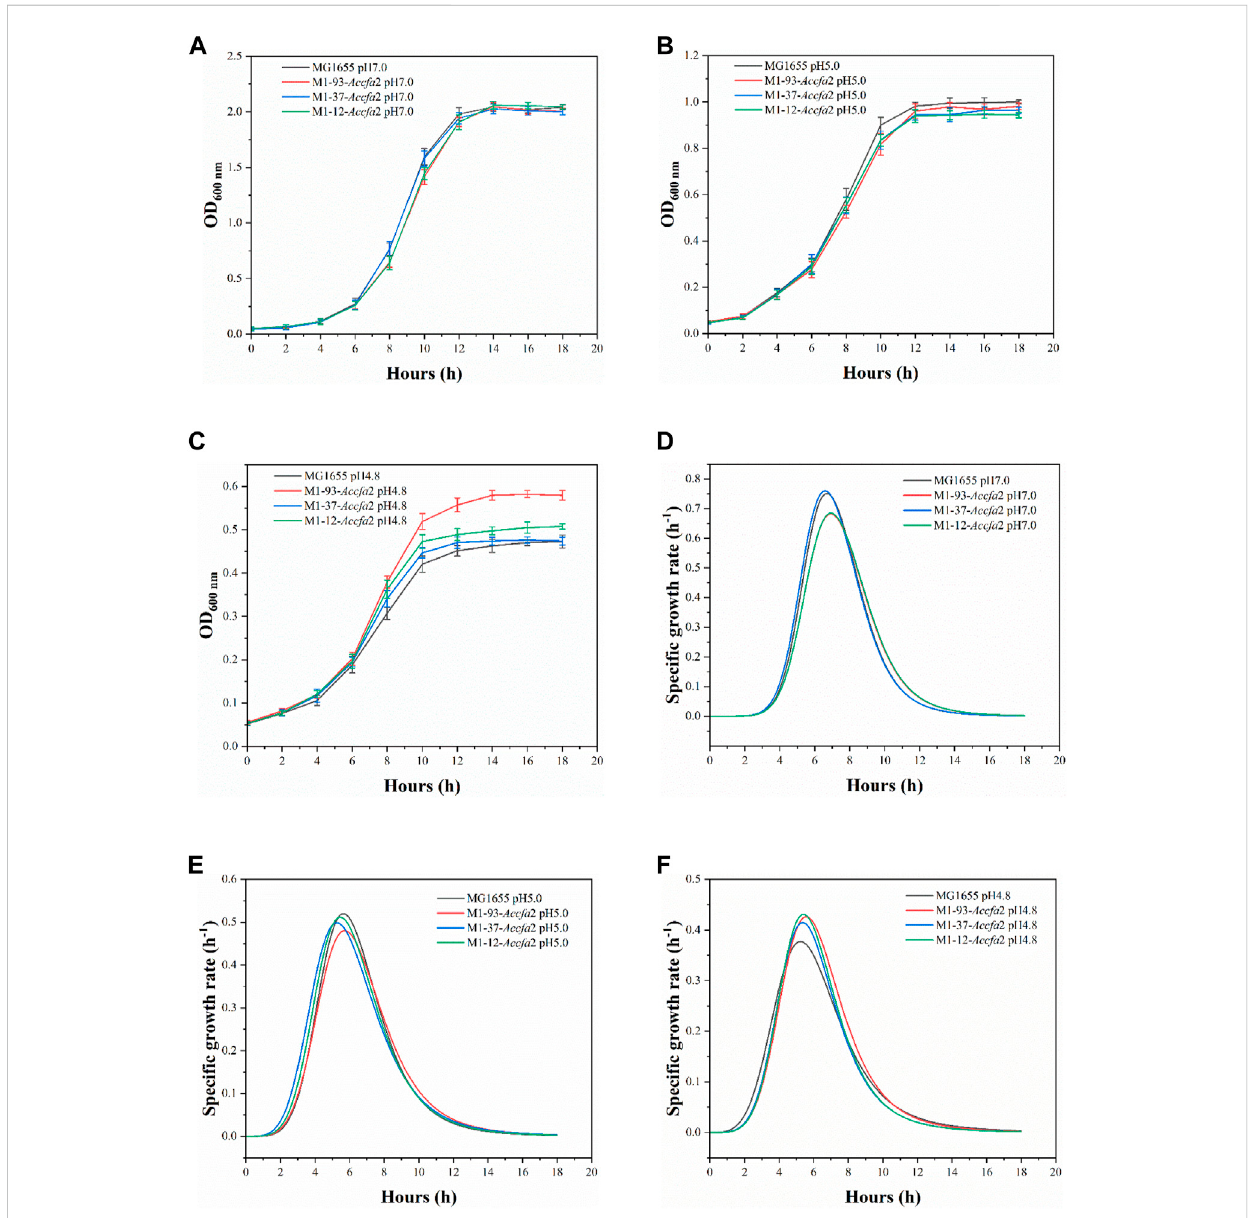
FIGURE 3 Theintegrationof Accfa 2intogenomicDNAof E.coli increaseditsresistancetosevereacidstress(pH4.8). (A – C) Thegrowthcurvesof E.coli under neutral (pH 7.0), moderate (pH 5.0) and severe acid stress (pH 4.8) conditions, respectively, and E minimal medium was used for incubation. (D – F) The speci fi c growth rate curves corresponding to the above three conditions, respectively. The error bars represented means ± standard deviations